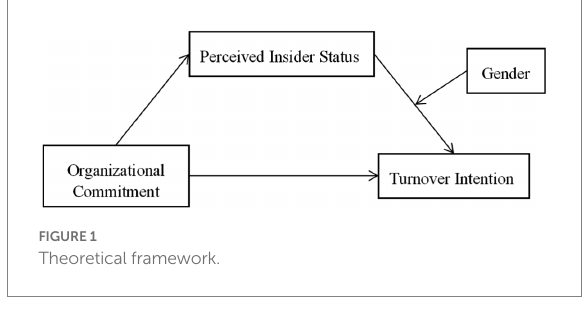
FIGURE 1 Theoretical framework.